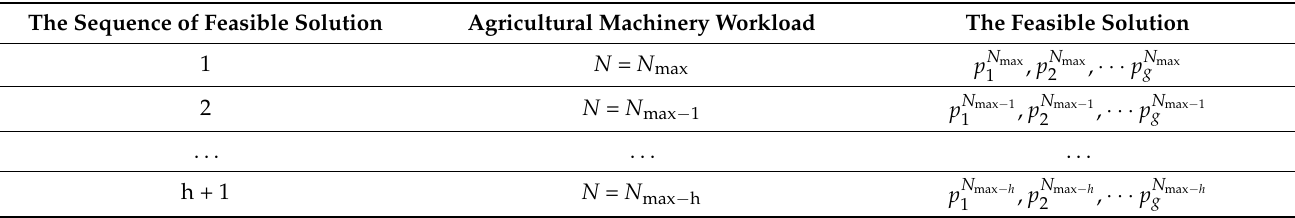
Table 3. The structure of the planning set.